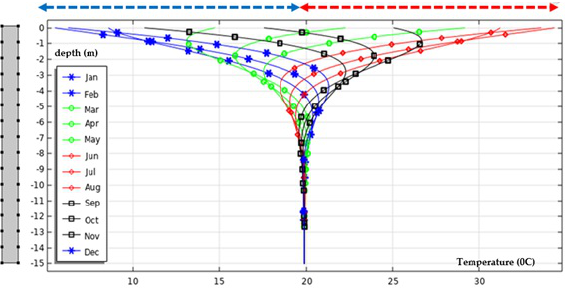
Fig. 5. Soil Temperature in the fourth year (analytical vs numerical)